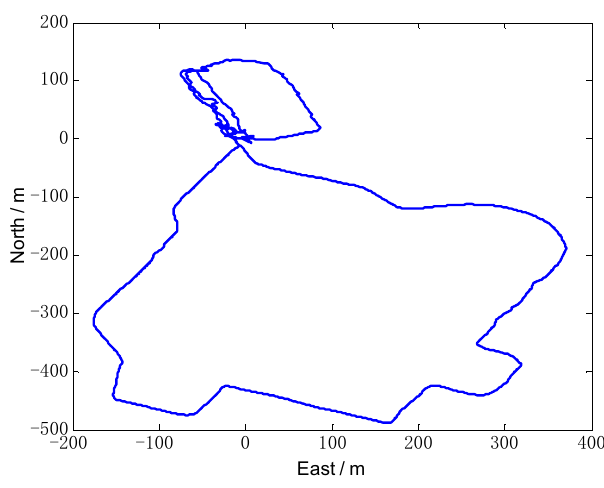
Figure 11. The vehicle test trajectory measured by GPS.